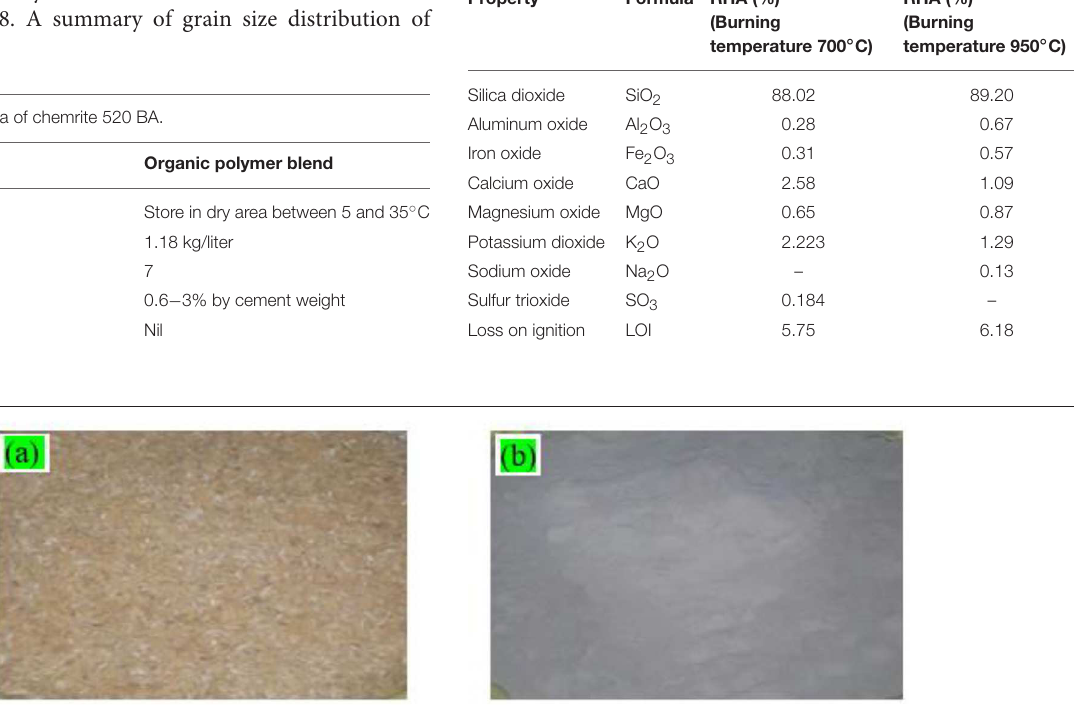
Frontiers in Materials |